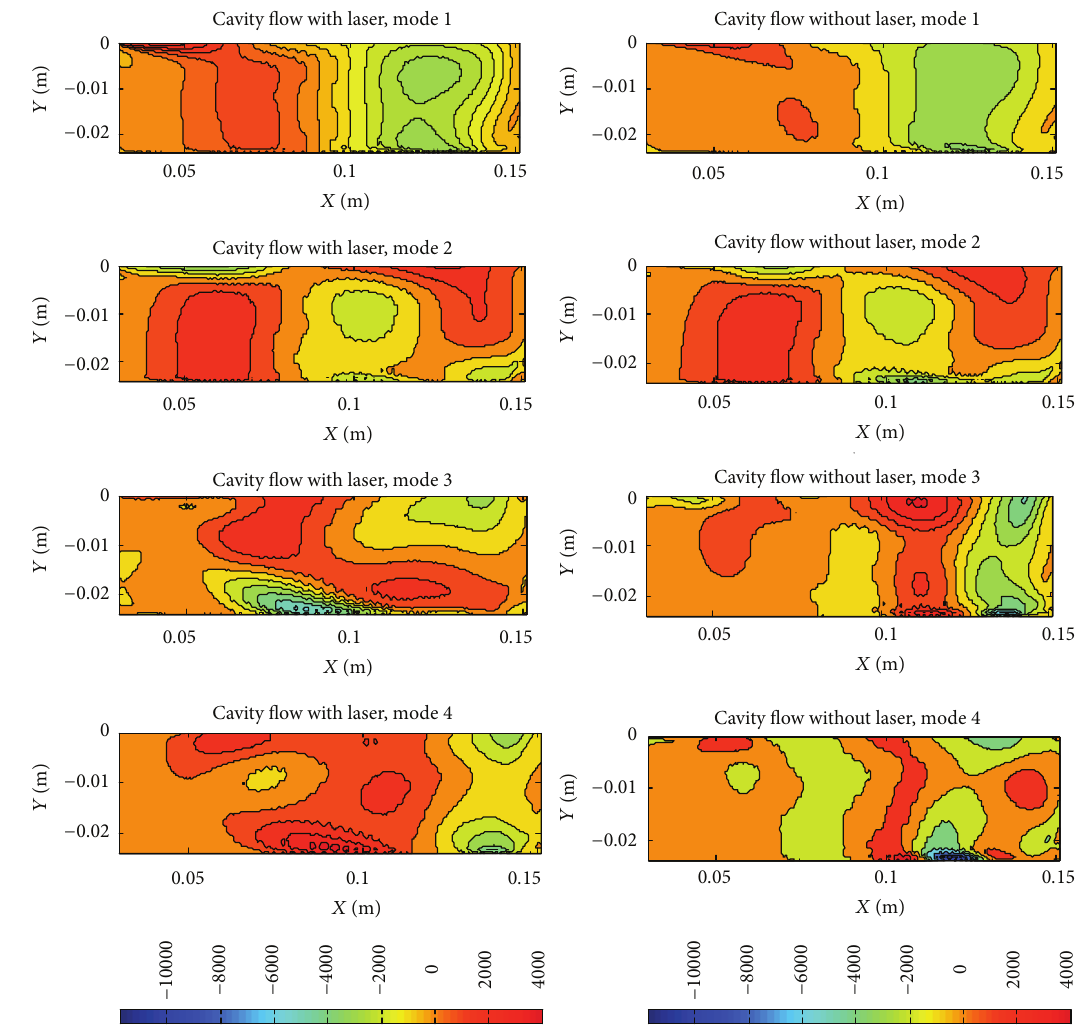
Figure 8: POD modes: with laser and without laser.